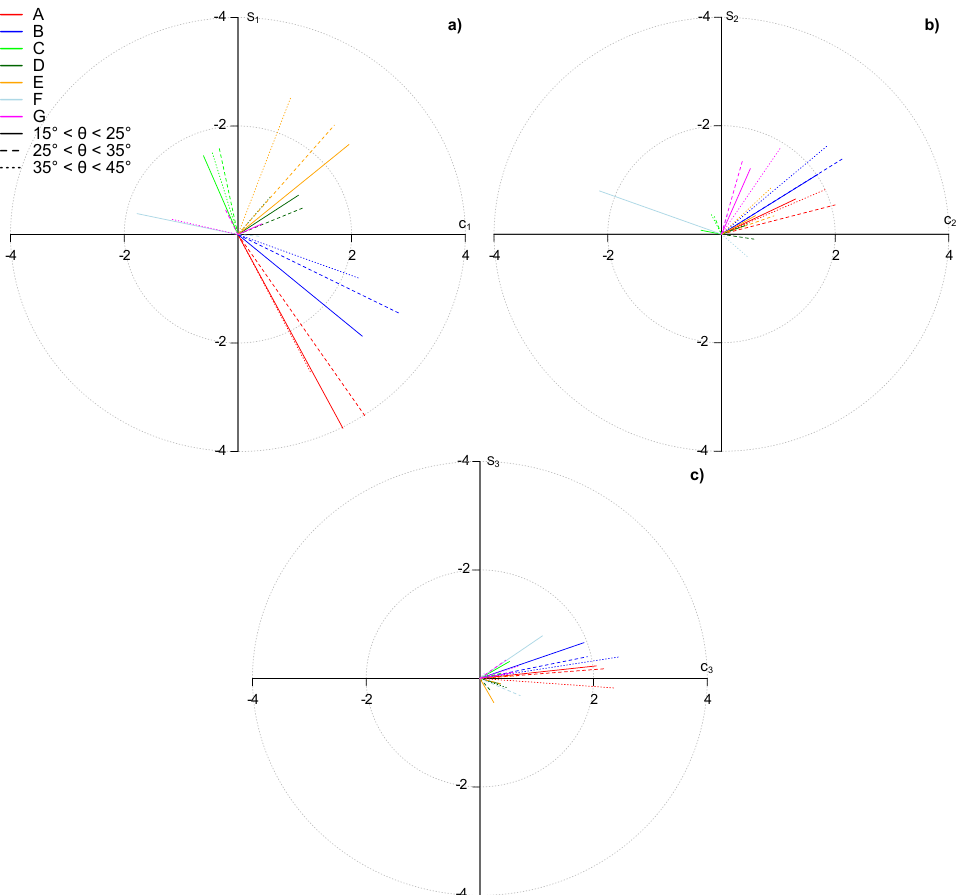
Figure 7. Fitted parameters c i , s i of harmonic model terms ( a ) i = 1; ( b ) i = 2 and ( c ) i = 3 for the different AOIs A–F and θ ranges. Line lengths represent amplitudes ( a ) A 1 ; ( b ) A 2 and ( c ) A 3 ; angles between the x axis and the lines represent phase angles ( a ) φ 1 ; ( b ) φ 2 and ( c ) φ 3